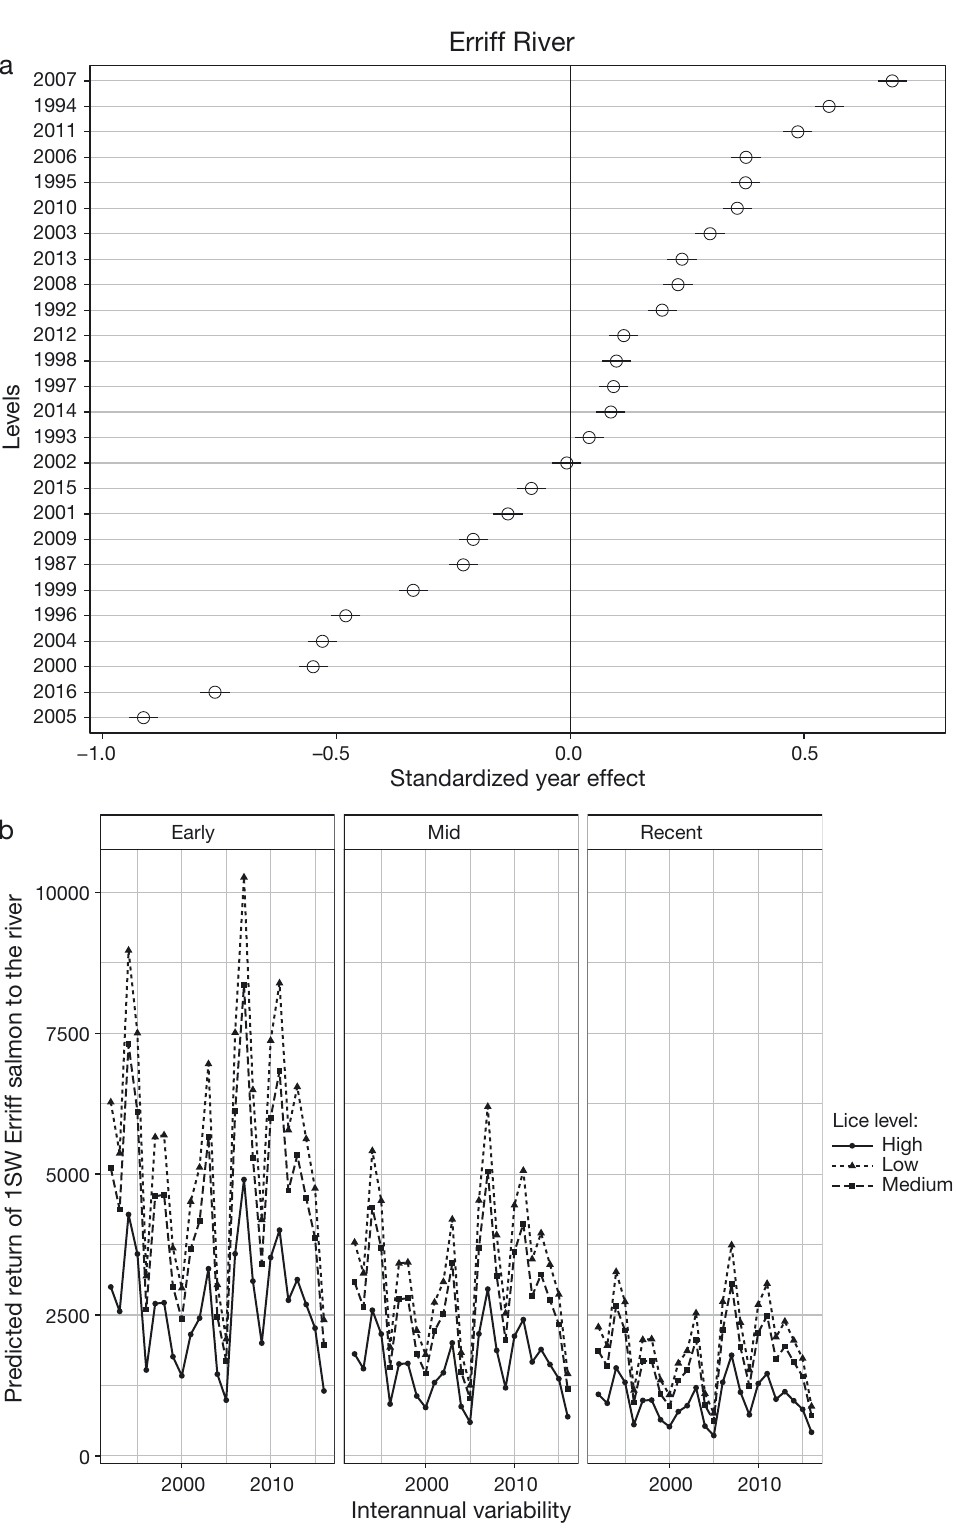
Fig. 5. (a,c) Random effects (with 95% CI) on the intercept of year ( Ycat i ) from the selected model (Model 7, Table 1) of returns of 1 sea-winter (1SW) Erriff River Atlantic salmon to (a) the river ( S iRiver ) and (c) the Irish coast ( S iCoast ). (b,d) Random year effect (assumed to express unexplained inter-annual variability) on predicted returns of these salmon to (b) the river and (d) the Irish coast in 3 different periods of the return time series (Early, Mid, Recent) and at 3 levels of estimated salmon lice infestation ( Lcat2 i ) on the Killary salmon